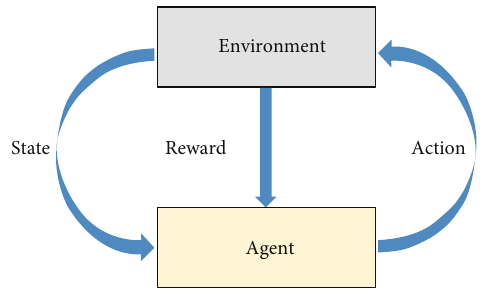
Figure 3: The typical framing of a reinforcement